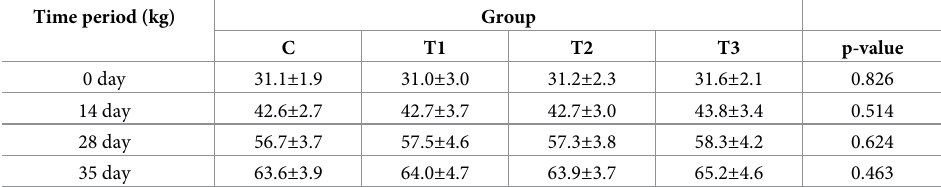
Table 6. Body weight of pigs´ during experiment.